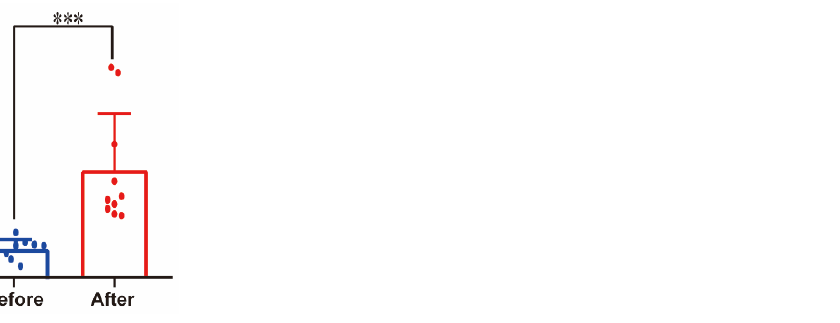
Figure 2. The concentration of protein present in urine before and after the combined simulated firefighting tests. *** p < 0.01.